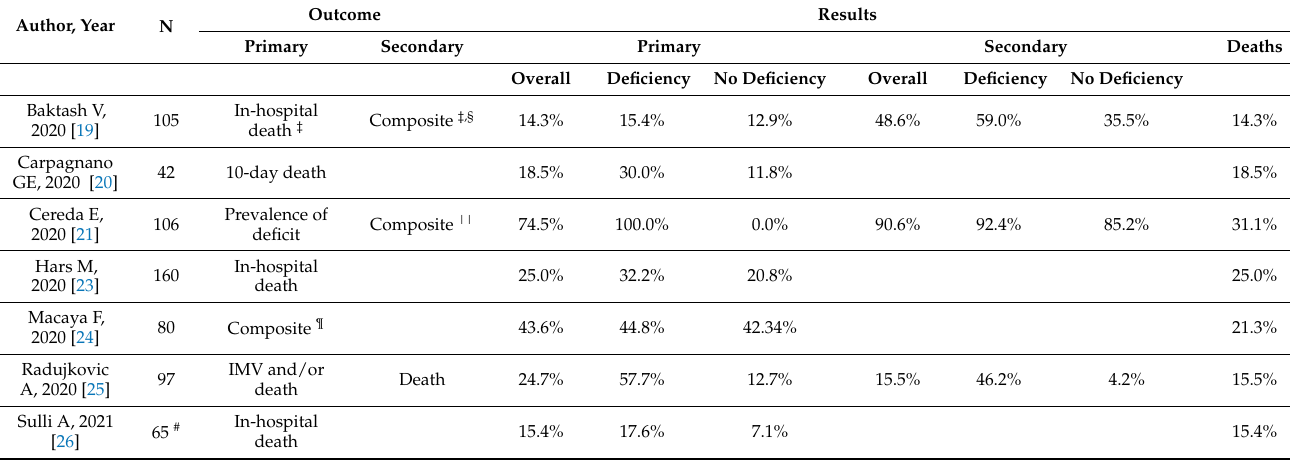
Table 4. Description of outcomes and results for the association between vitamin D status and COVID-19 in elderly patients.